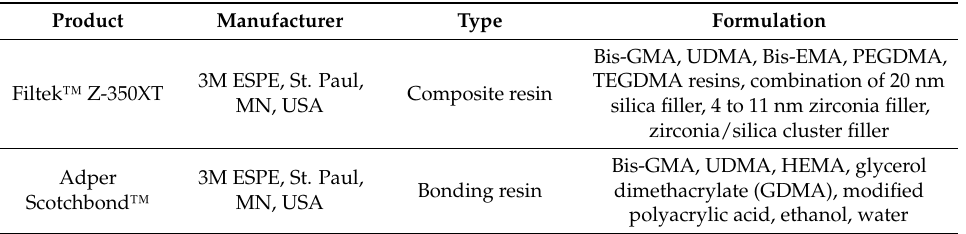
Figure 1. A representative illustration of the different sample preparation methods. ( a ) Samples were used without any curing; ( b ) samples were cured on agar with a light curing unit for 20 s; ( c ) samples were used after polymerization; ( d ) samples were polymerized and the unreacted resin monomer layer was removed afterward. Table 1. Summary of commercially available materials used for the cytotoxicity evaluation.